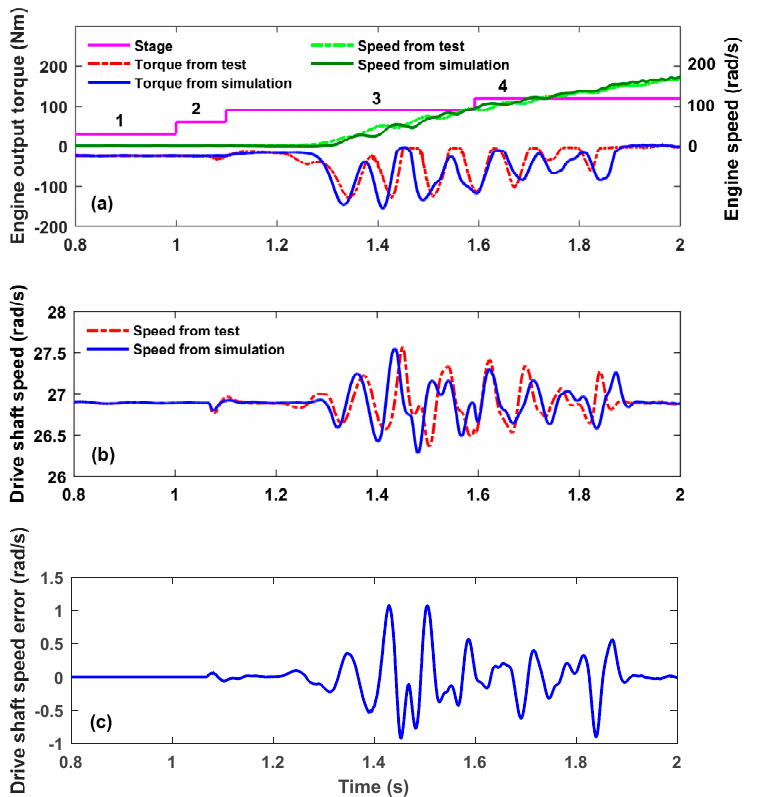
Figure 5. Model validation of the powertrain system: (a) engine output torque; (b) drive shaft speed; (c) drive shaft speed error.